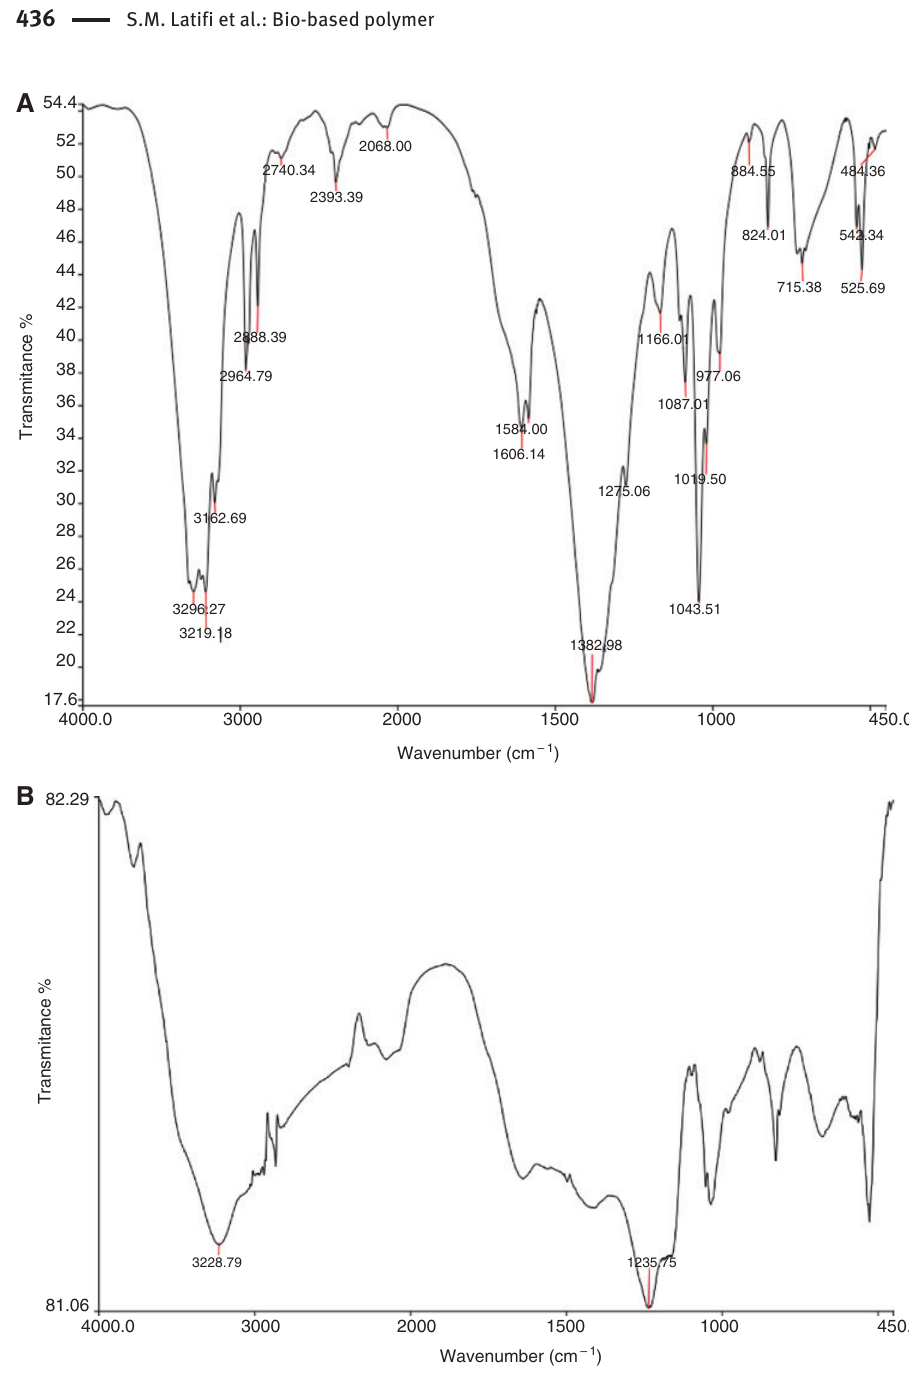
Figure 3: FT-IR spectra of (A) bis(ethylenediamine)copper(II) nitrate and (B) tris(ethylenediamine)nickel(II)